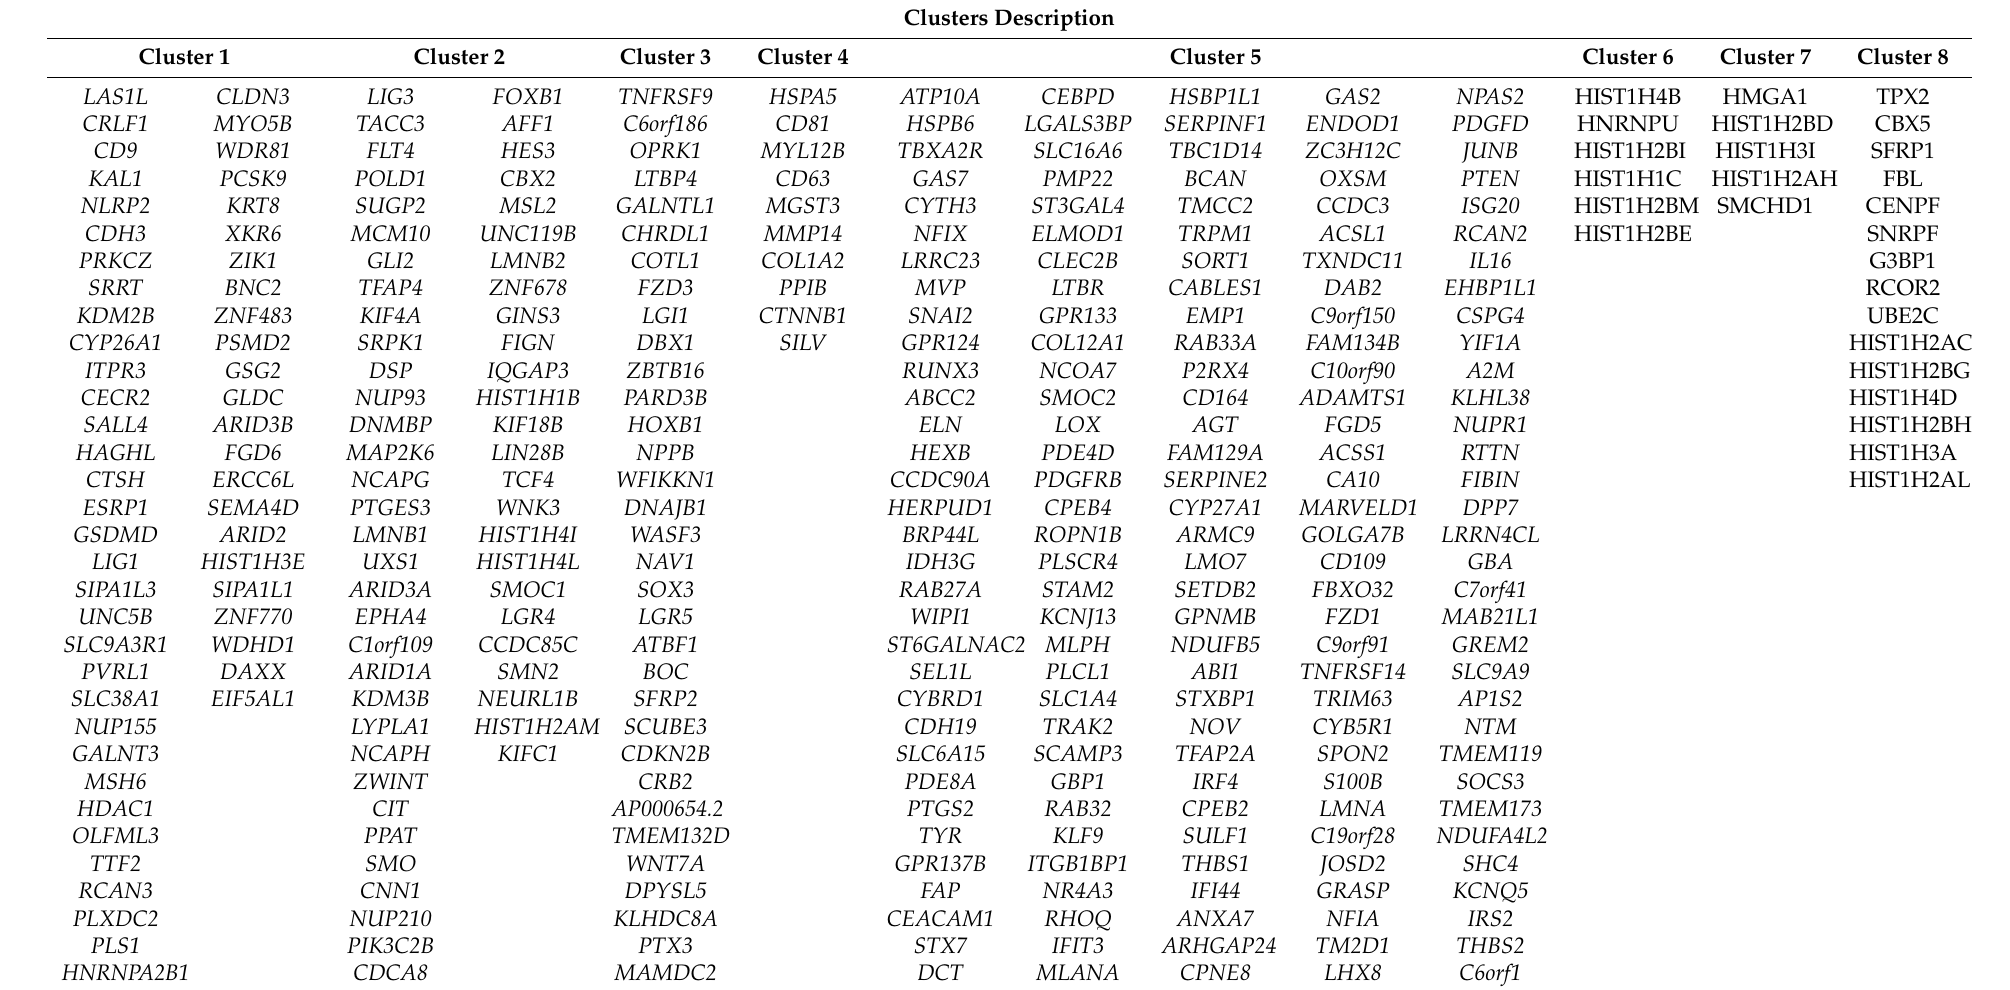
Table 1. Description of gene clusters. Relative to Figure